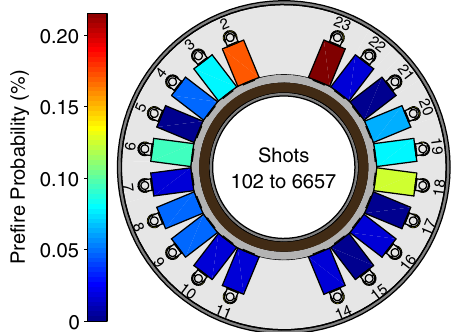
FIG. 11. Distribution of identifiable prefire events in the 100-GW LTD cavity. The plot shows probability (in percent) of a “ verified ” prefire at each of the 20 bricks in the cavity over the course of about 6,556 shots. For the most recent 1,733 shots there has only been two verified prefires, as shown in Fig.